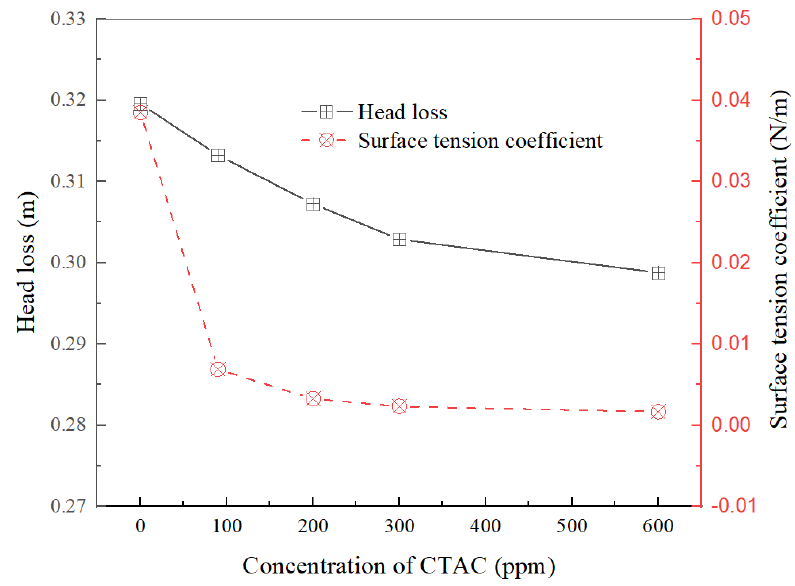
Figure 13. The head loss and surface tension in the sudden-contraction pipe.